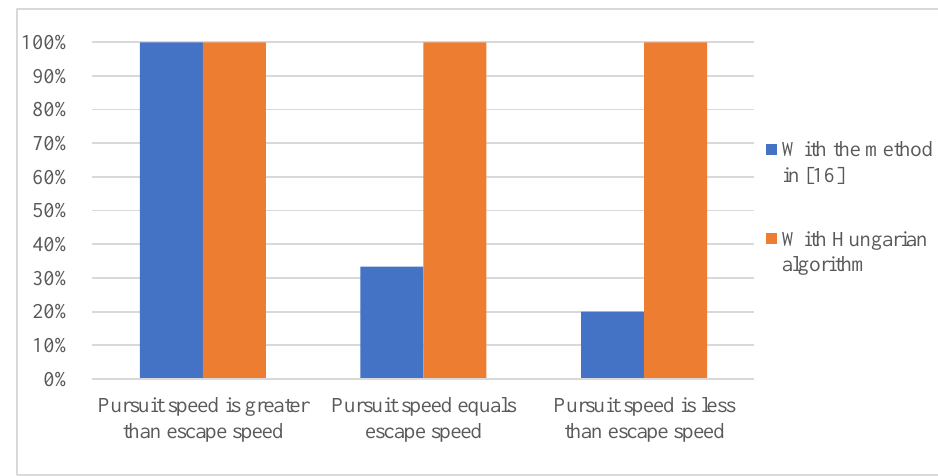
Figure 11. Statistical table of the pursuit results of the different pursuit strategies.